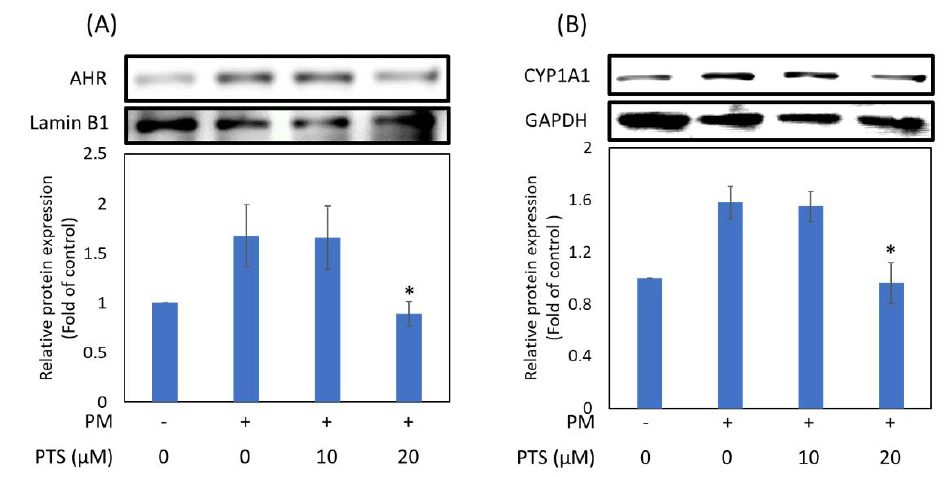
Figure 3. PTS inhibited AHR translocation and CYP1A1 expression. ( A ) AHR in nucleus and ( B ) CYP1A1 total protein. n = 3 for each group; * p < 0.05 compared with only PM exposure.